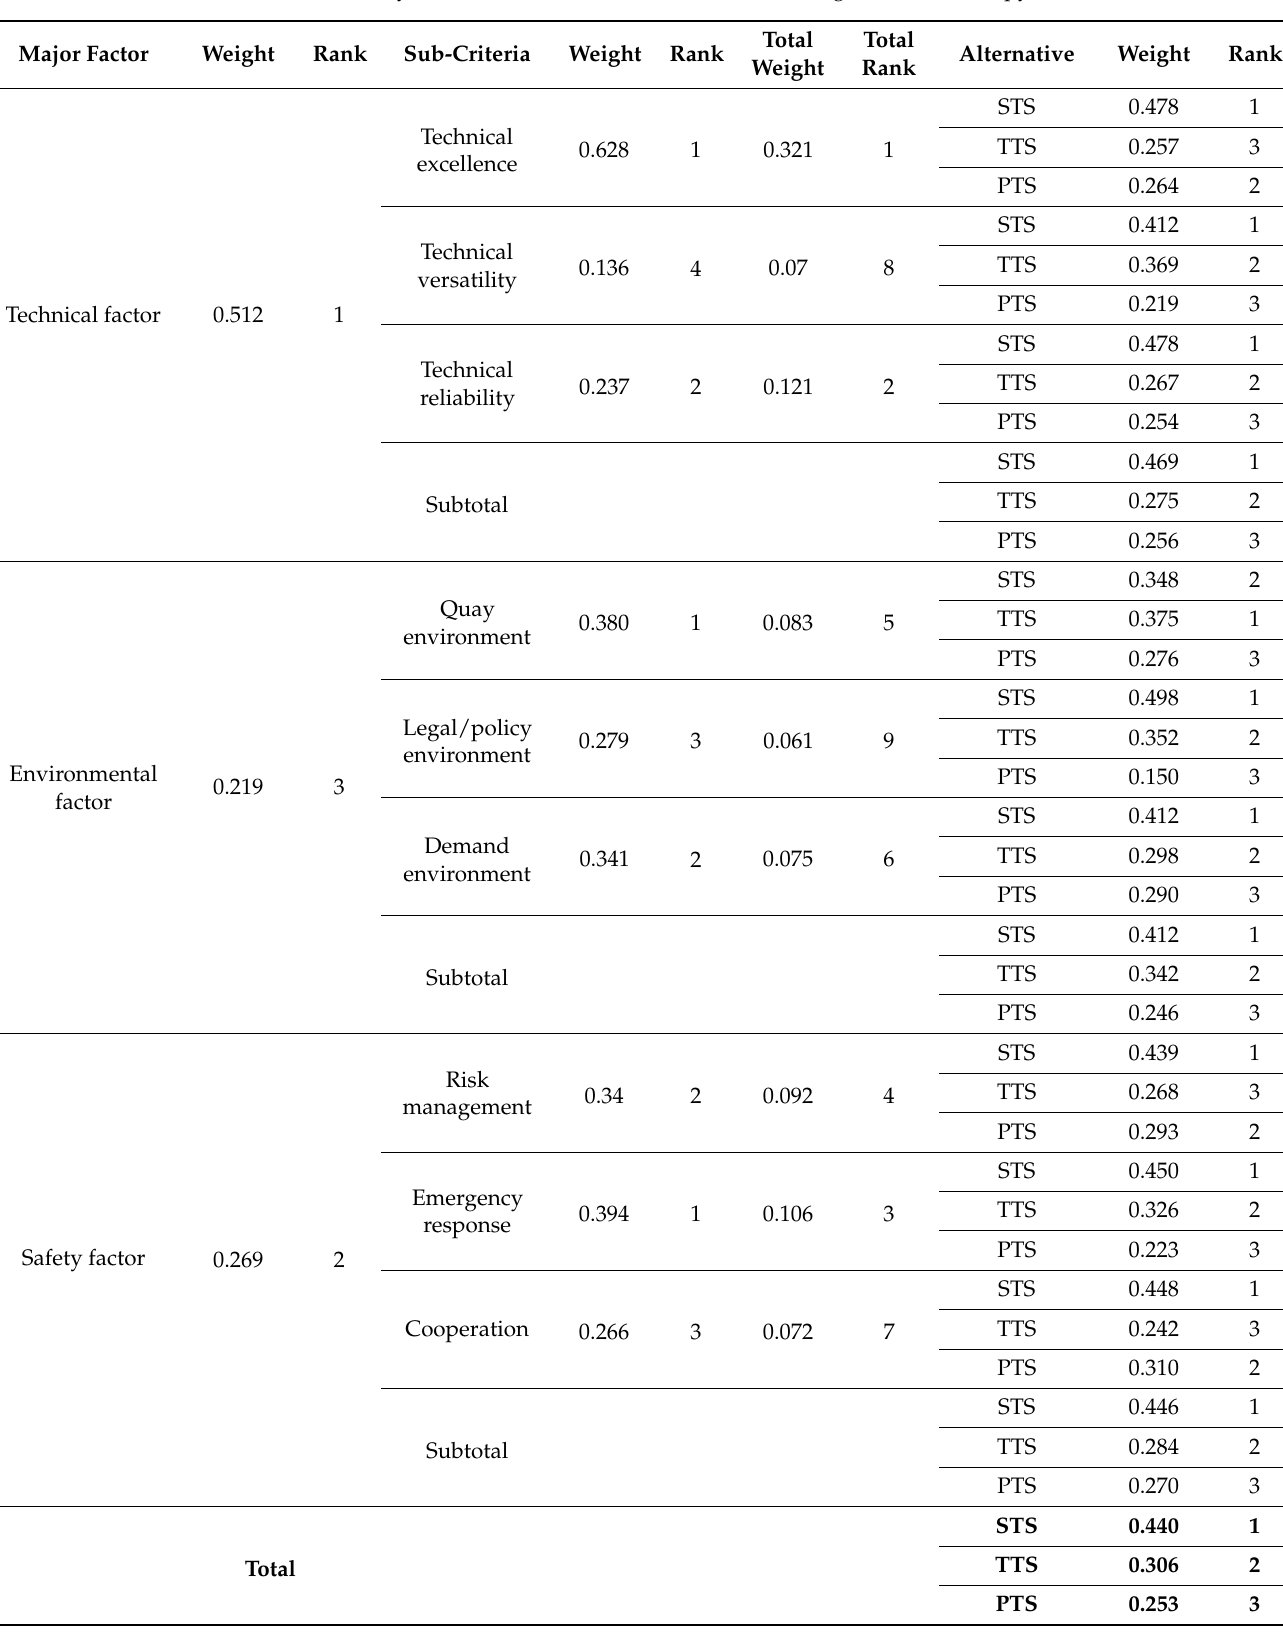
Table 6. AHP analysis result on the selection of LNG bunkering method in a